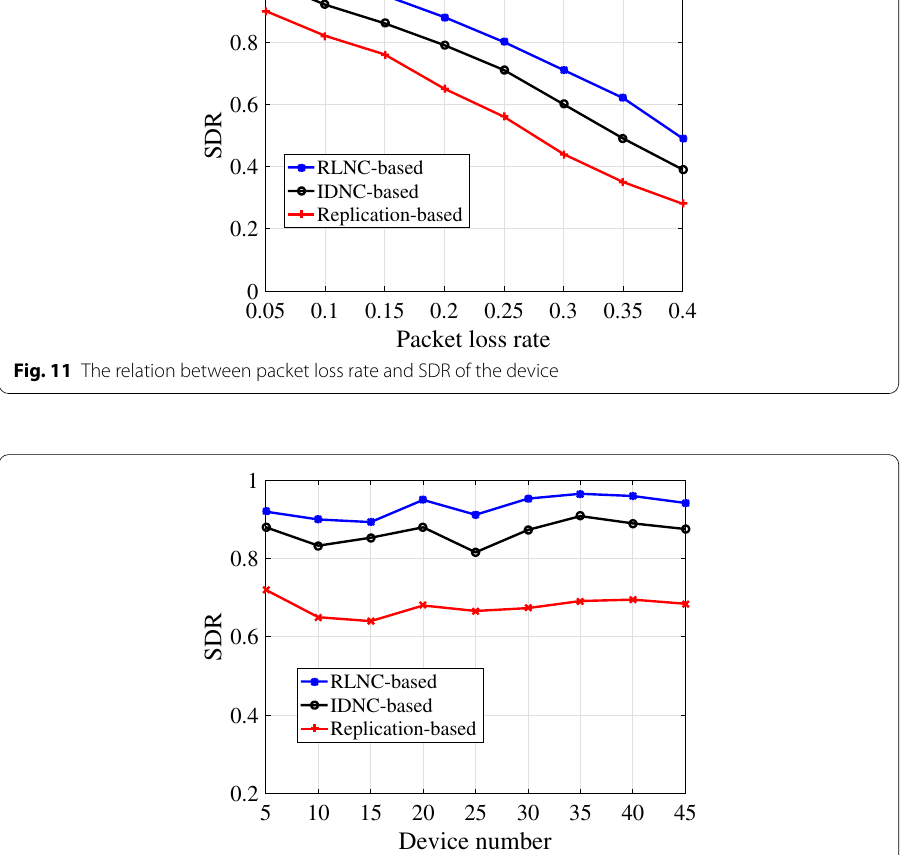
Fig. 12 The relation between the number of devices and the SDR of